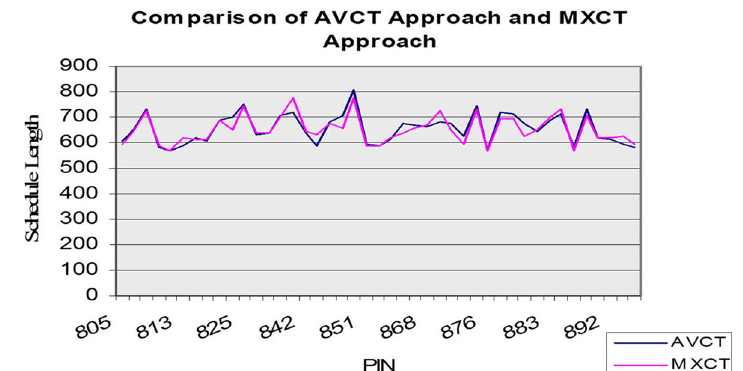
Fig. 9 Variations in schedule length obtained from the AVCT approach and MXCT approach